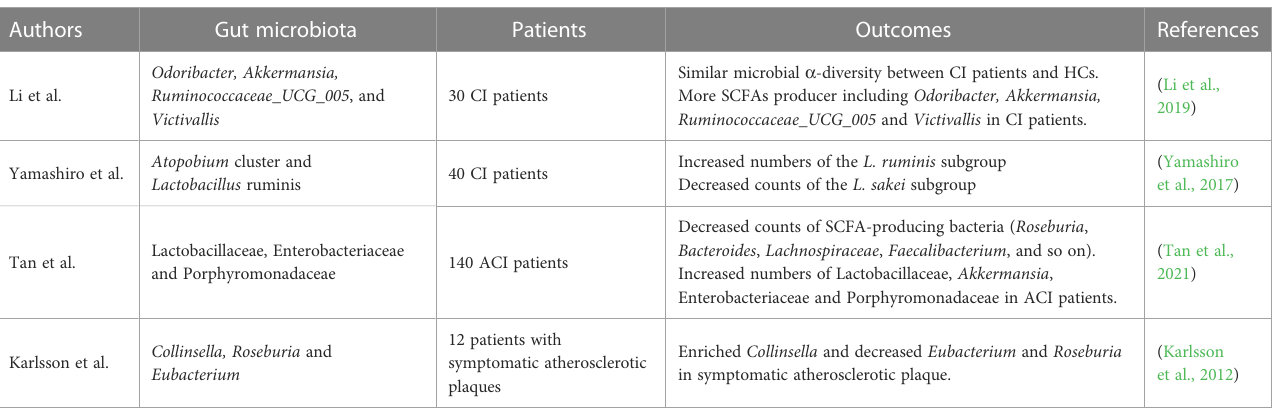
TABLE 1 Changes of gut microbiota in cerebral